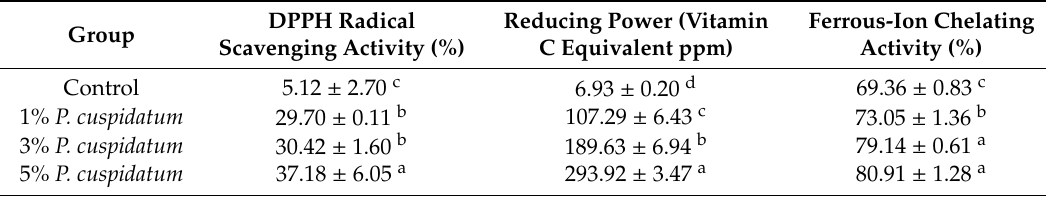
Table 1. DPPH free radical scavenging activity, ferrous ion chelating activity and reducing power of resveratrol-enriched rice wine. Control was performed without the addition of P. cuspidatum . DPPH Radical Reducing Power Group Scavenging Activity (%)